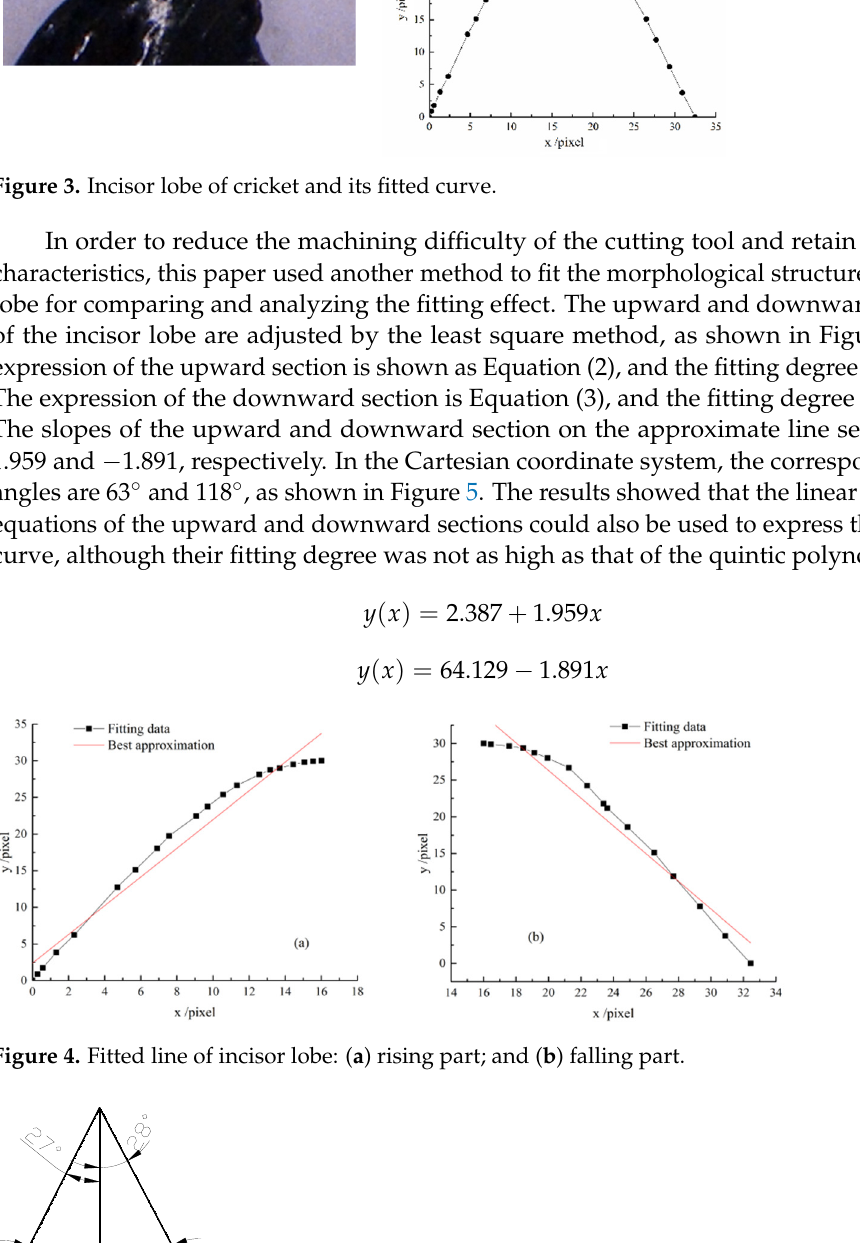
Figure 4. Fitted line of incisor lobe: ( a ) rising part; and ( b ) falling part.